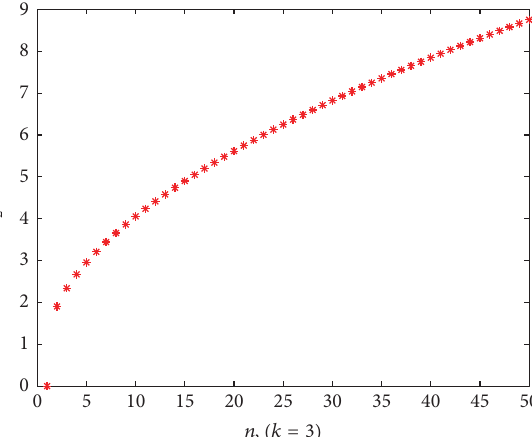
Figure 5: The 𝐻 2 norm for topology 𝐾 𝑛 ∘ 𝑃 3 .